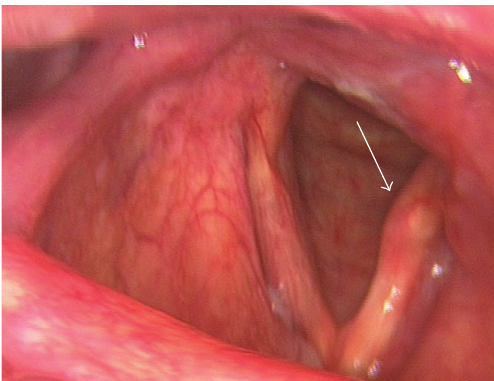
Figure 1: 56-year-old male with chronic thromboembolic pulmonary hypertension and sudden hoarseness. Appearance of the paralysed left vocal cord (white arrow) during fiberoptic laryngoscopy, no malignant lesion was detected in this examination.